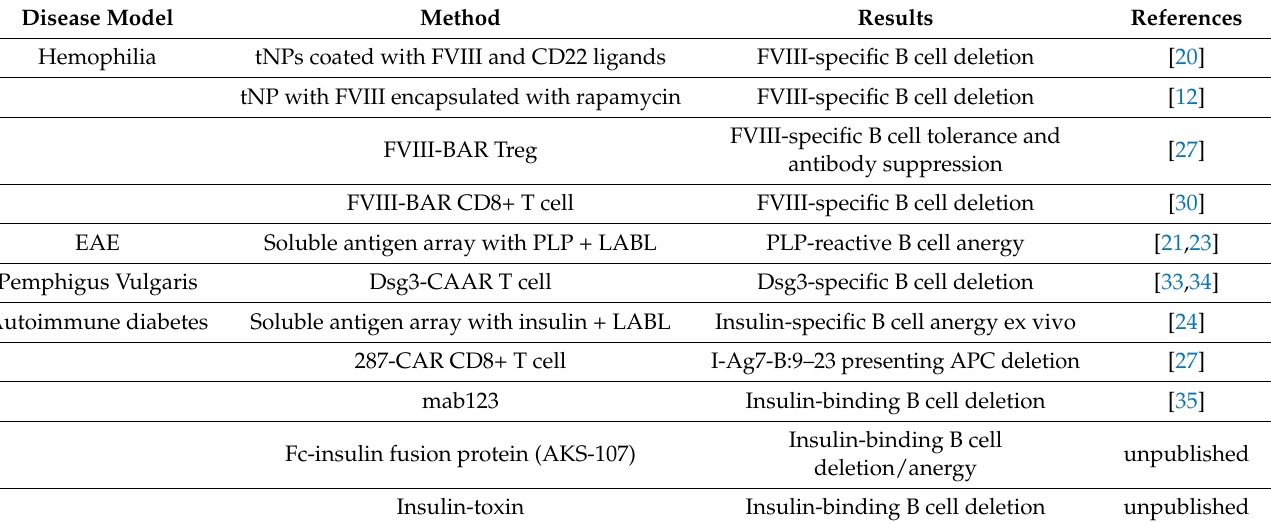
Table 1. Summary of antigen-specific B cell therapies to